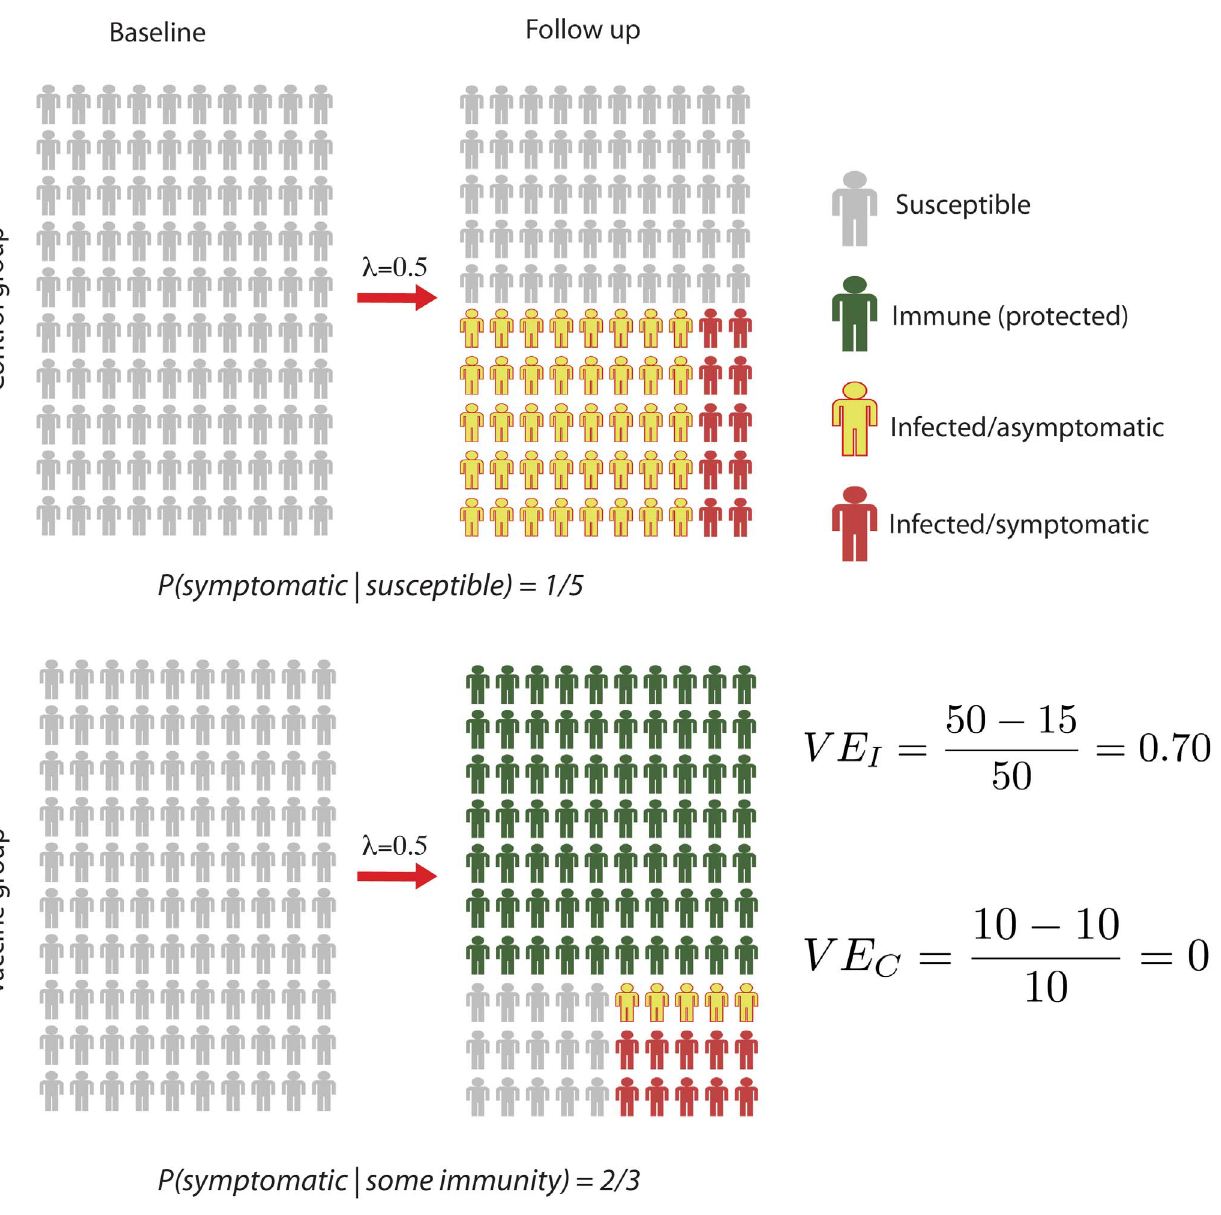
Figure 1. Figure showing the lack of agreement that might exist between VE I and VE C . In this example, VE I is 0.7. However, since the vaccine also increases the probability of symptomatic disease by a factor of 3.3, VE C is